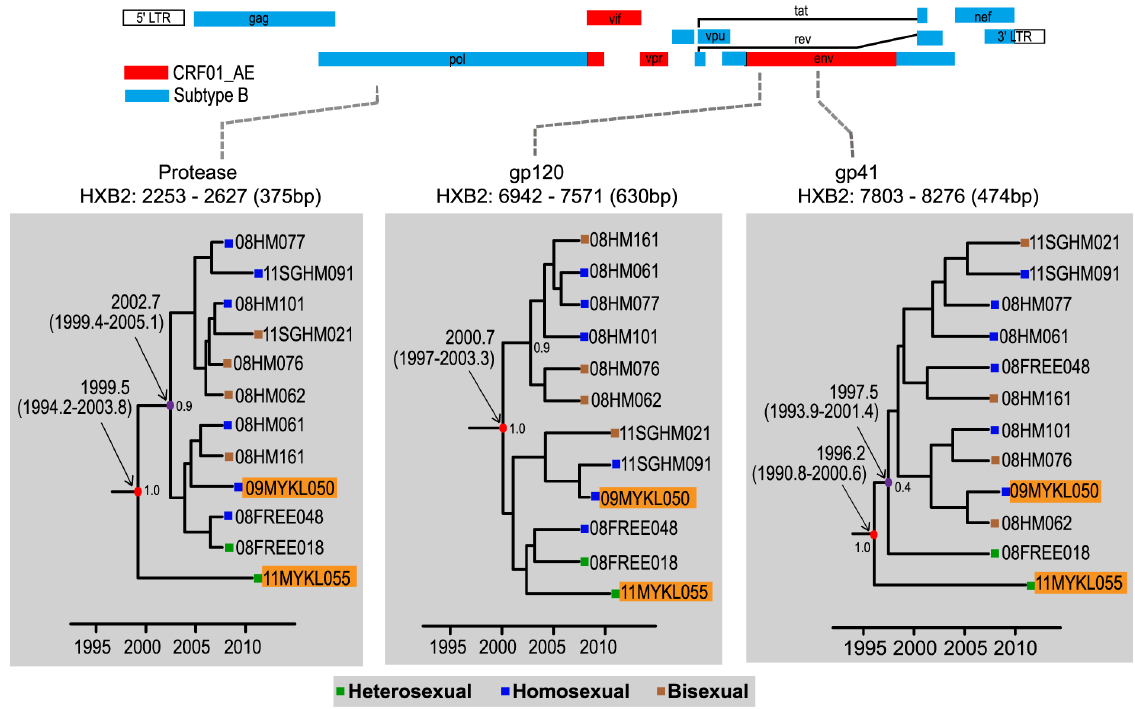
Figure 2. Maximum clade credibility (MCC) trees reconstruction of CRF51_01B isolated in Singapore and Malaysia. MCC trees for protease (subtype B, HXB2:2253–2627, 375 bp), gp120 (CRF01_AE, HXB2:6942–7571, 630 bp) and gp41 regions (subtype B, HXB2:7803–8276, 474 bp) are shown. Timescale is shown at the bottom of the tree. The mean tMRCA and 95% highest probability density (HPD) for the key nodes are indicated. CRF51_01B strains from Malaysia are highlighted in orange.